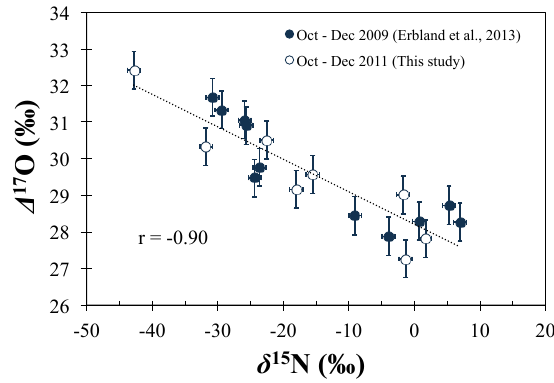
Figure 8. Relationship observed between the δ 15 N and (cid:49) 17 O val- ues of atmospheric nitrate present at Dome C between October and December during both the 2009 and 2011 summer campaigns. Error bars indicate the typical analytical uncertainties associated with the